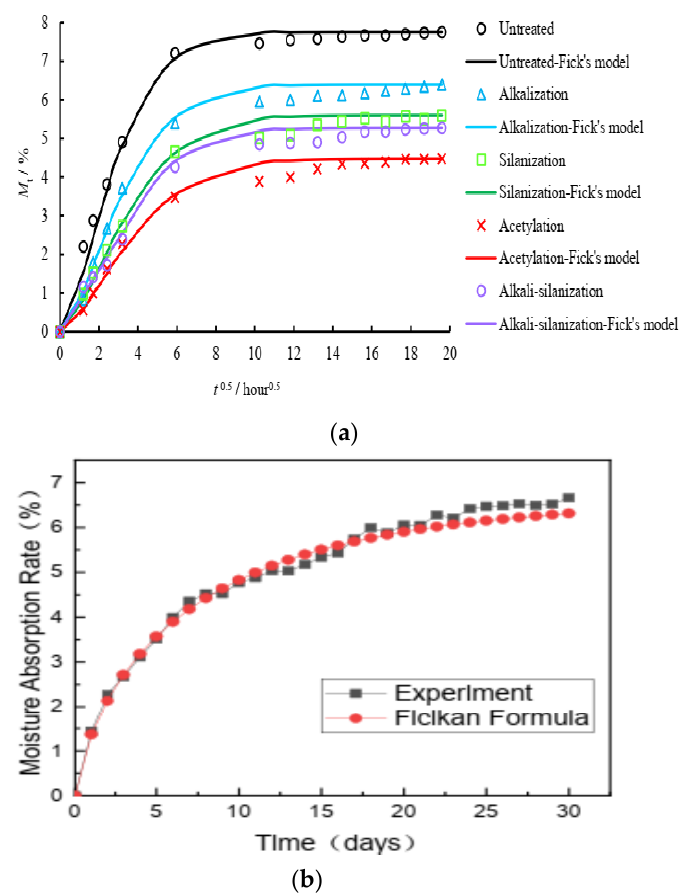
Figure 3. ( a , b ) Hygrothermal aging curves of polymer composites (Adapted from the references [49,55]).